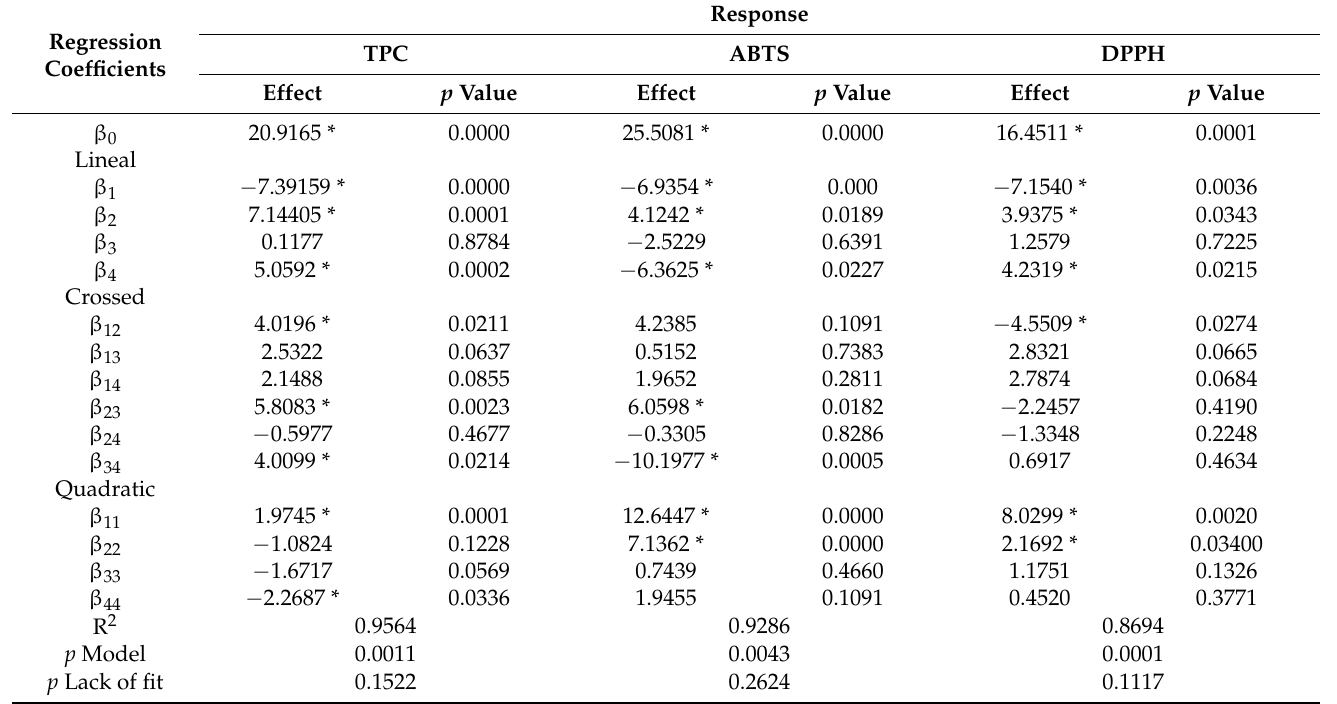
Table 2. Estimated regression coefficients of the adjusted second-order polynomial equation and analysis of variance (ANOVA) of the